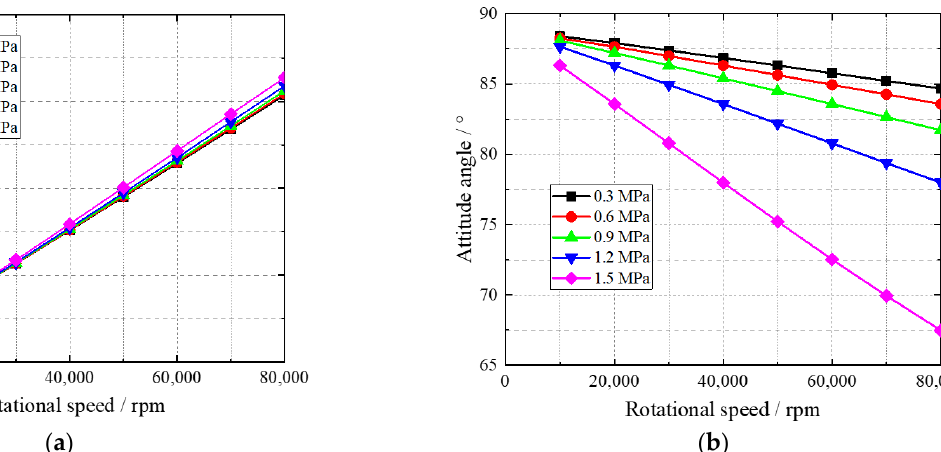
Figure 9. ( a ) Bearing load capacity and ( b ) attitude angle of hydrogen gas bearings with ambient pressure.